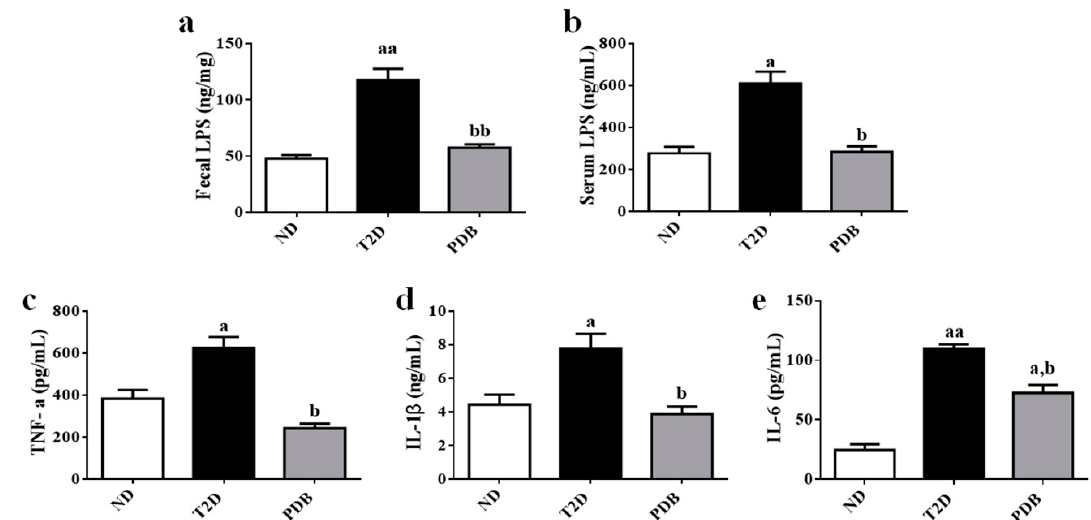
Figure 2. Effects of PDB on systemic endotoxemia and inflammation of type 2 diabetic (T2D) mice. The fecal lipopolysaccharide (LPS) ( a ), serum LPS ( b ), serum TNF- α ( c ), serum IL-1 β ( d ), and IL-6 ( e ) were determined by ELISA kits. Data are presented as mean ± SD, n=6. a p < 0.05, aa p < 0.01 versus the normal diet (ND) group. b p < 0.05, bb p < 0.01 versus the T2D group.